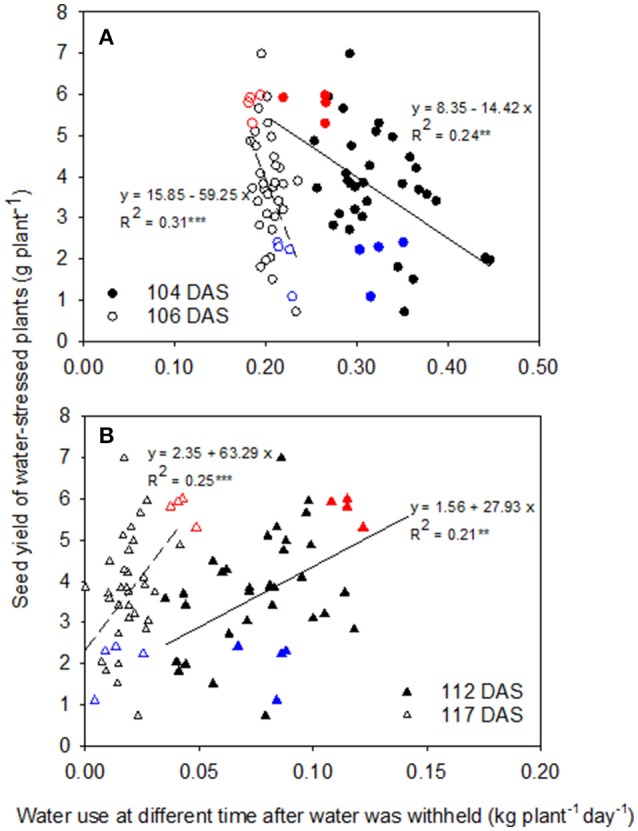
Relationships between seed yield and water use in the water-stressed (WS) treatment at 4 and 6 days after water was withheld (DAWW) (104 and 106 days after sowing (DAS), respectively, A), and 12 and 17 DAWW (112 and 117 DAS, respectively, B) in 10 chickpea genotypes. The fitted linear regressions with regression coefficients (R2) are given. **P < 0.01; ***P < 0.001. Red and blue symbols represent Neelam and CICA0912, respectively.